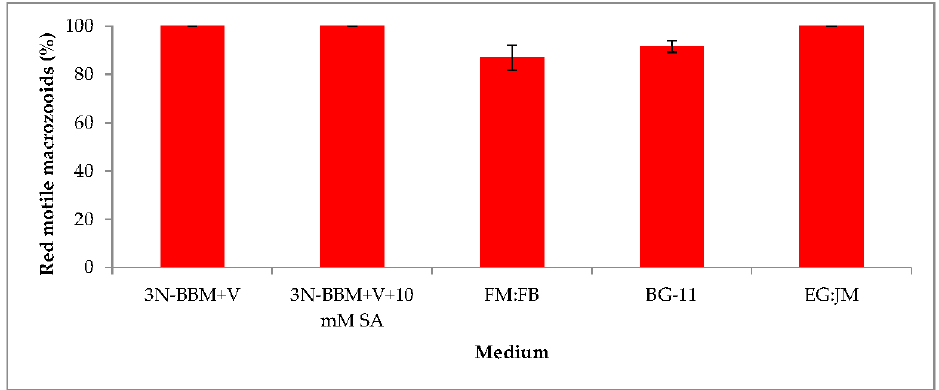
Figure 6. Percentage of red motile H. pluvialis macrozooids produced in the red stage after cultivation of H. pluvialis in a range of media. Mean % red motile macrozooids on day 12 ± S.D. ( n = 3). Green stage involved culturing at 20 °C, 40 µmol photons m − 2 ·s − 1 , 12:12 photoperiod, 150 rpm for 10 days. Red stage involved culturing at 20 °C, continuous light at 240 µmol photons m − 2 ·s − 1 for 12 days.